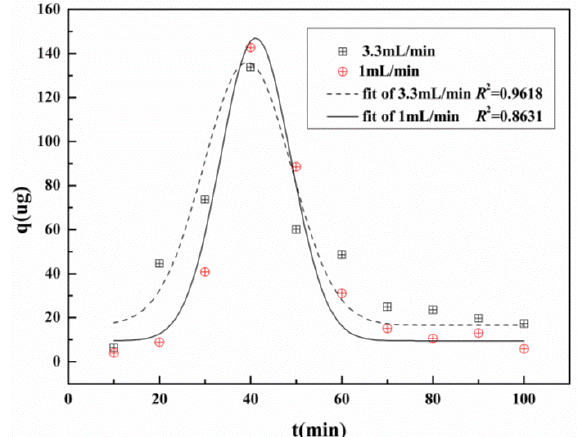
Figure 8. Dynamic desorption curves of 1-DNJ with 732 resins under different flow